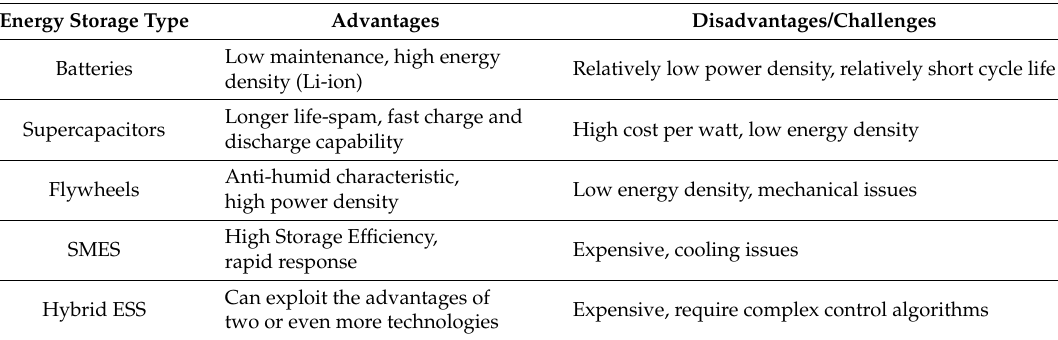
Table 5. Advantages and Disadvantages of Different Storage